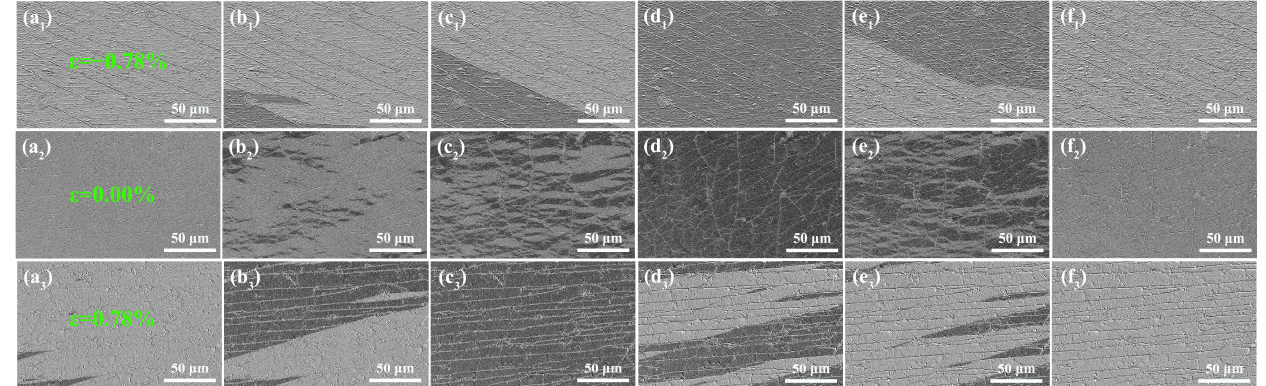
Figure 7. MOKE images of Ti/Fe/Ni 81 Fe 19 /Fe/Ti multilayer films. (( a 1 )–( f 1 )) indicate variations in the magnetic domain under an external strain of ε = − 0.78%: ( a 1 ) − 0.94 mT, ( b 1 ) − 1.10 mT, ( c 1 ) − 1.20 mT,